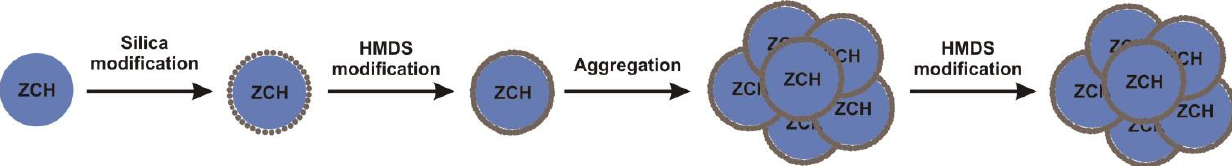
Figure 7. Schematic representation of the synthesis of surface-modified ZnO ultrafine particles using an in situ modification method (created based on [41] with permission from Elsevier